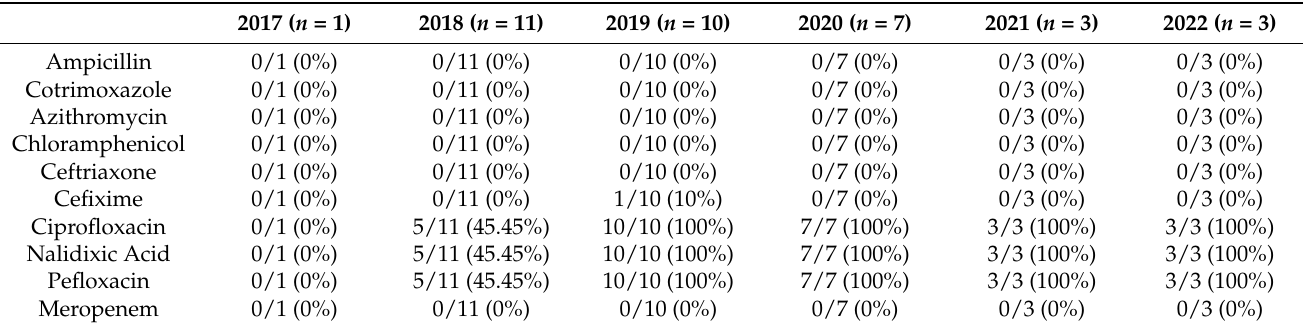
Table 5. Percentages (%) of antibiotic resistance that were found in the Salmonella Typhi isolates against different antibiotics across 5 years (2017–2022).